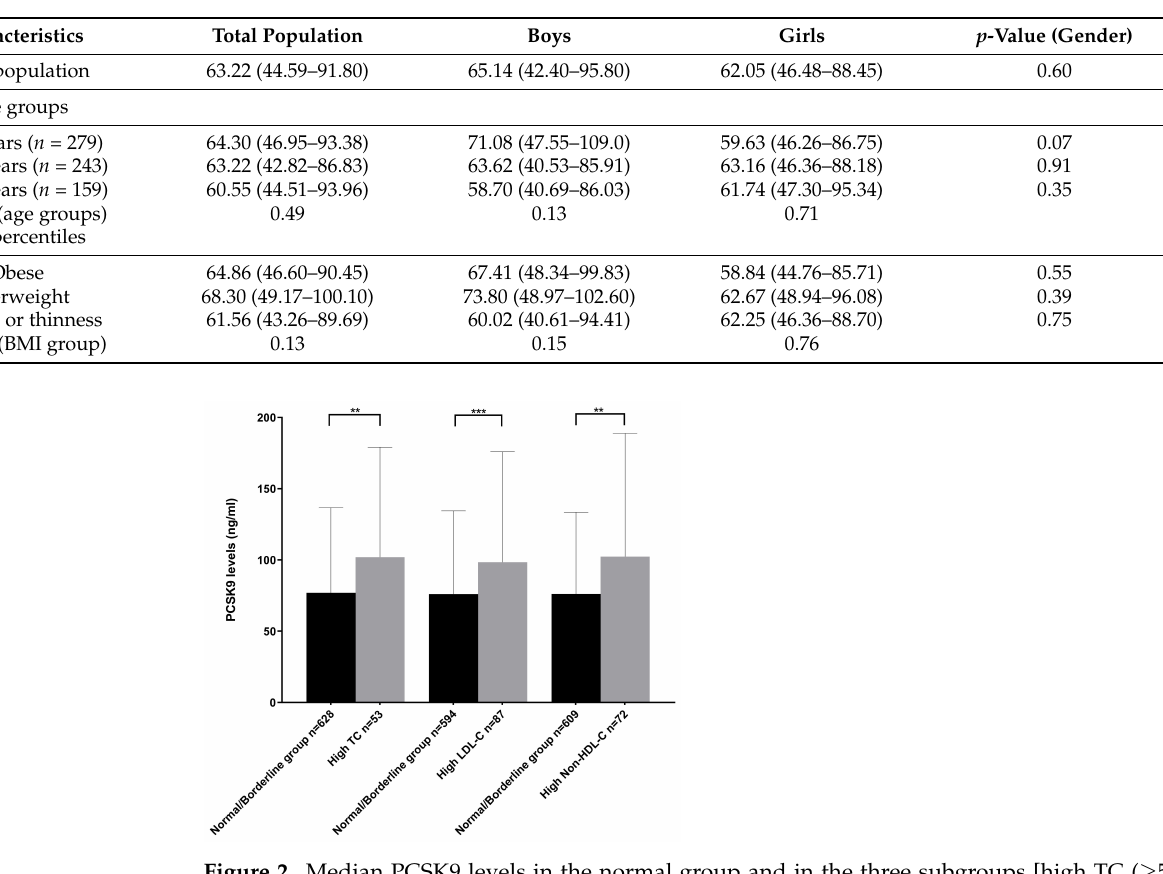
Figure 2. Median PCSK9 levels in the normal group and in the three subgroups [high TC ( ≥ 5.2 mmol/L), high LDL-C ( ≥ 3.4 mmol/L), high Non-HDL-C ( ≥ 3.8 mmol/L)]. ** p = 0.001, *** p =